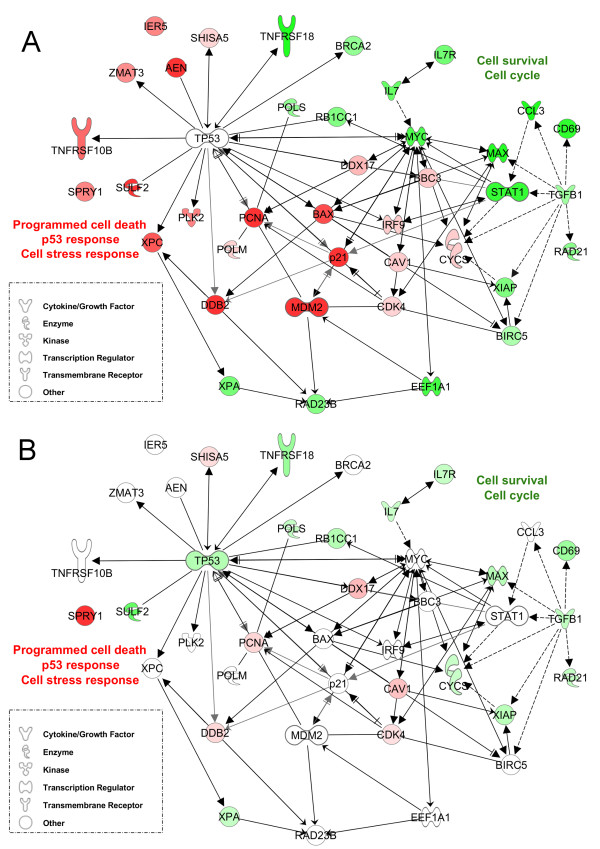
Molecular interaction network of fludarabine-regulated genes in cells of sensitive CLL patients in vivo. A group of genes highly regulated by fludarabine in sensitive patients (following a 24h exposure in vivo) was clustered in a network around the transcription regulators TP53 and MYC using the Ingenuity Pathway Analysis software (IPA 8.0, database Nov 2009). A, Gene expression values obtained from sensitive patients were overlaid on the network. B. Gene expression values obtained from resistant patients were overlaid on the network.